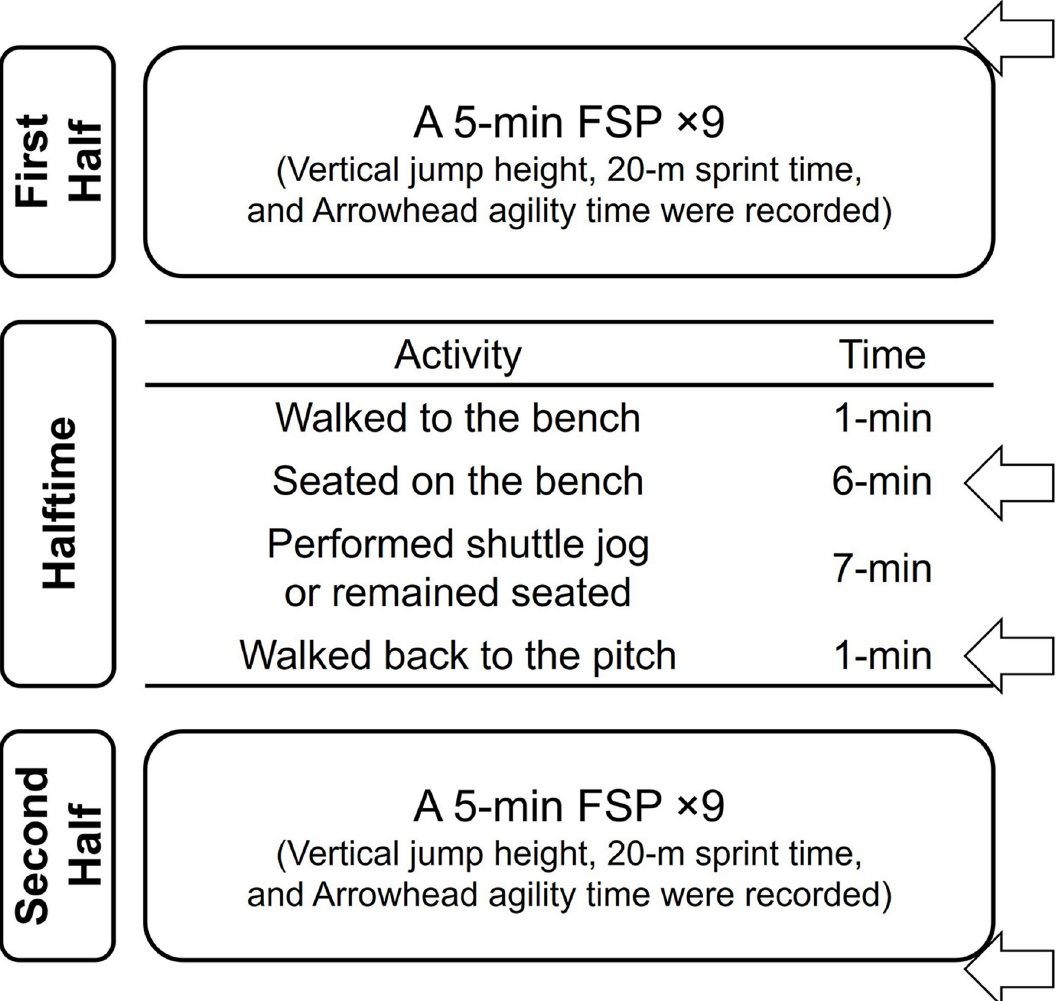
Fig 2. Testing procedures. Subjects were randomly experienced the condition of shuttle jog or seated rest each session. Heart rate was recorded throughout the experiment. The arrows indicate time points for lower-leg temperature measurements. FSP: football simulation